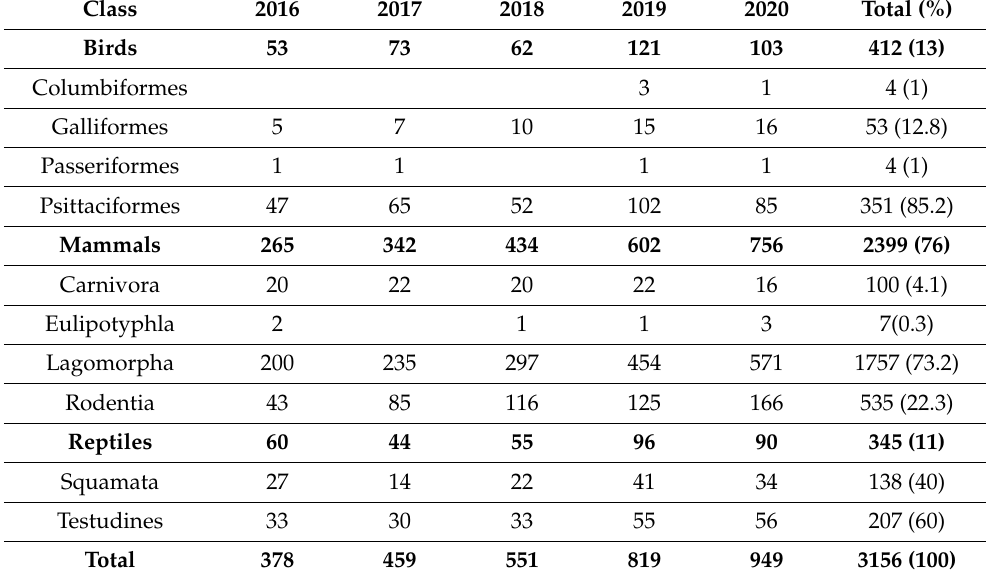
Table 2. Number and frequency of exotic pet cases analyzed by animal class and years studied from the